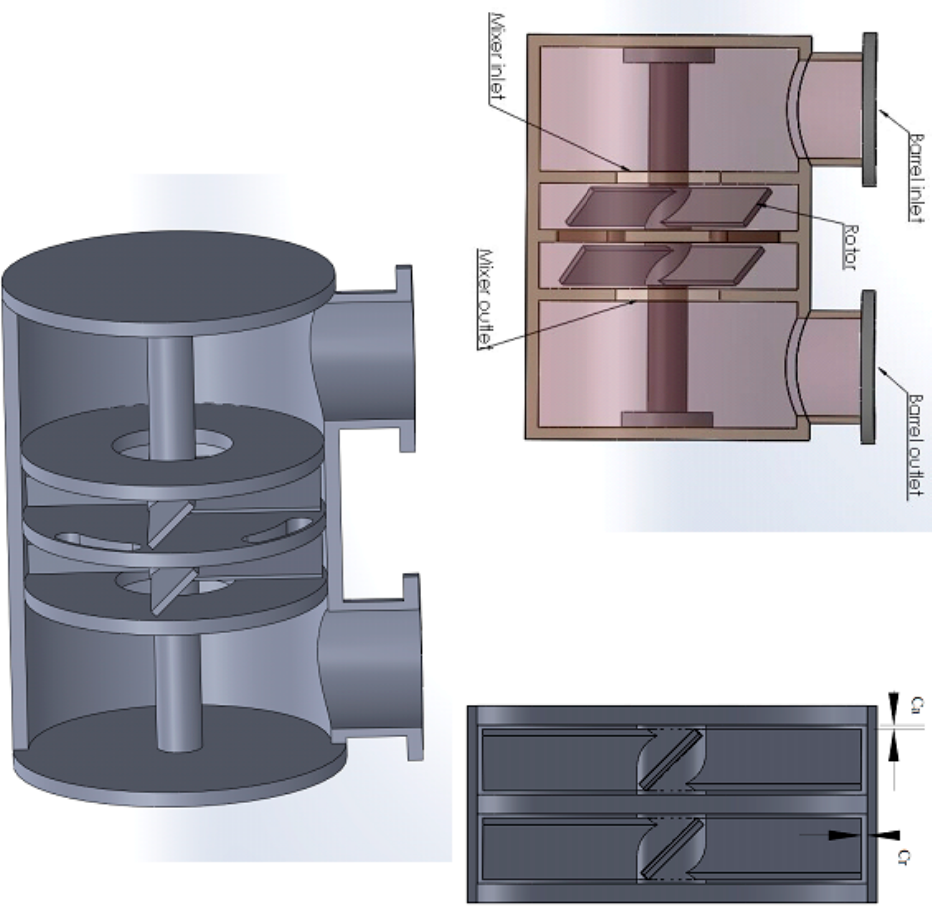
Figure 1. Geometrical description of the in-line rotor-stator